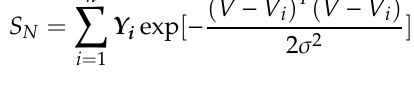
Figure 10. The new prototype with eddy current sensors; ( a ) ball; ( b ) ball housing; ( c ) new prototype.